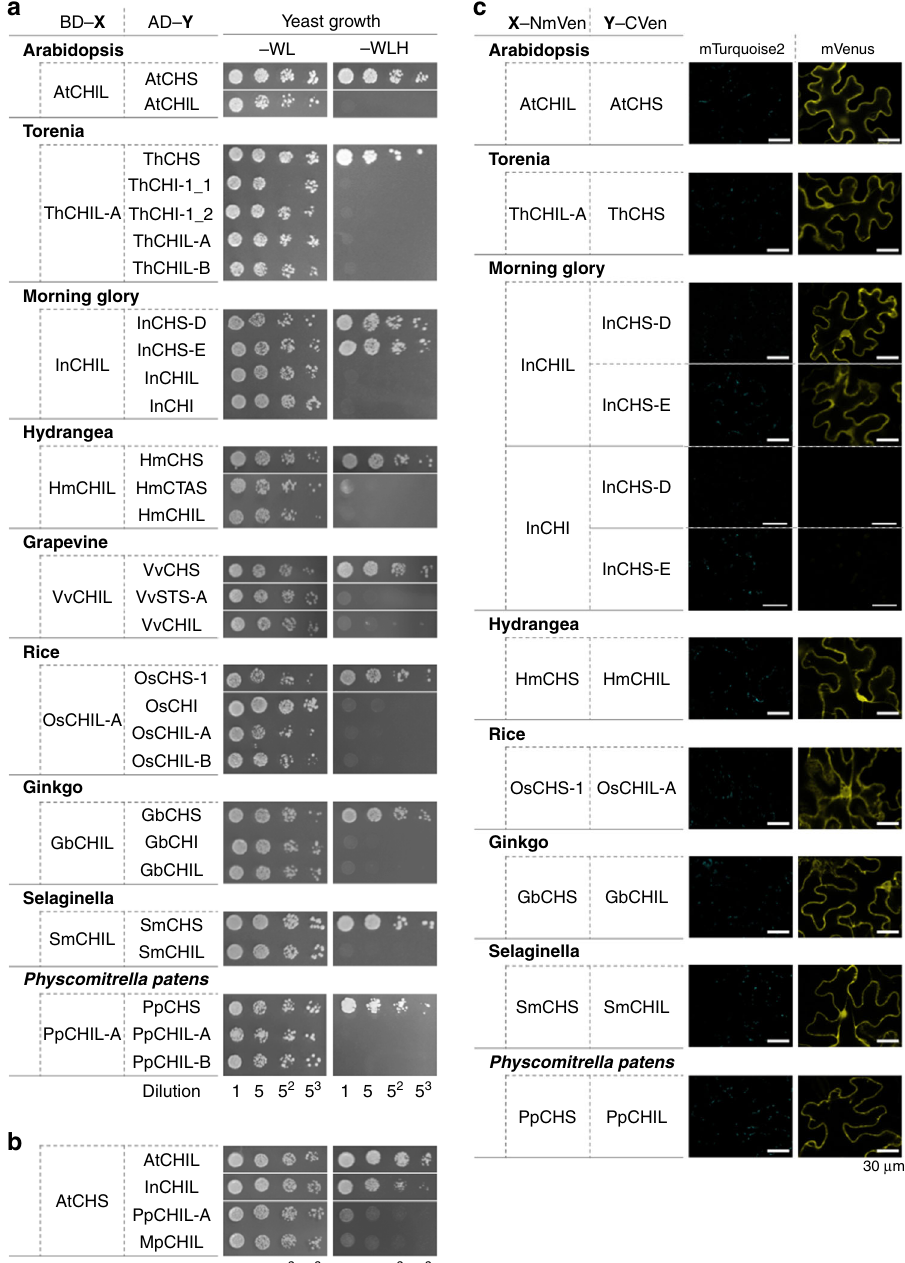
Fig. 3 Binary interactions between CHIL and CHS in land plants. a Interactions of CHIL with CHS and related proteins were analyzed in various land plants with the GAL4-based yeast two-hybrid system. HmCTAS and VvSTS refer to a p -coumaroyltriacetic acid synthase of hydrangea and a stilbene synthase isozyme of grapevine, respectively. Refer to the Fig. 2 legend for details regarding the other protein names and the abbreviated growth media names. b Interactions of heterologous CHILs with AtCHS. c Interactions of CHIL with CHS from various land plants were analyzed in Nicotiana benthamiana leaf cells by BiFC. The BiFC results for the CHI and CHS isozymes of morning glory (InCHI and InCHS-D/InCHS-E, respectively) are provided as negative controls. Scale bars = 30 μ